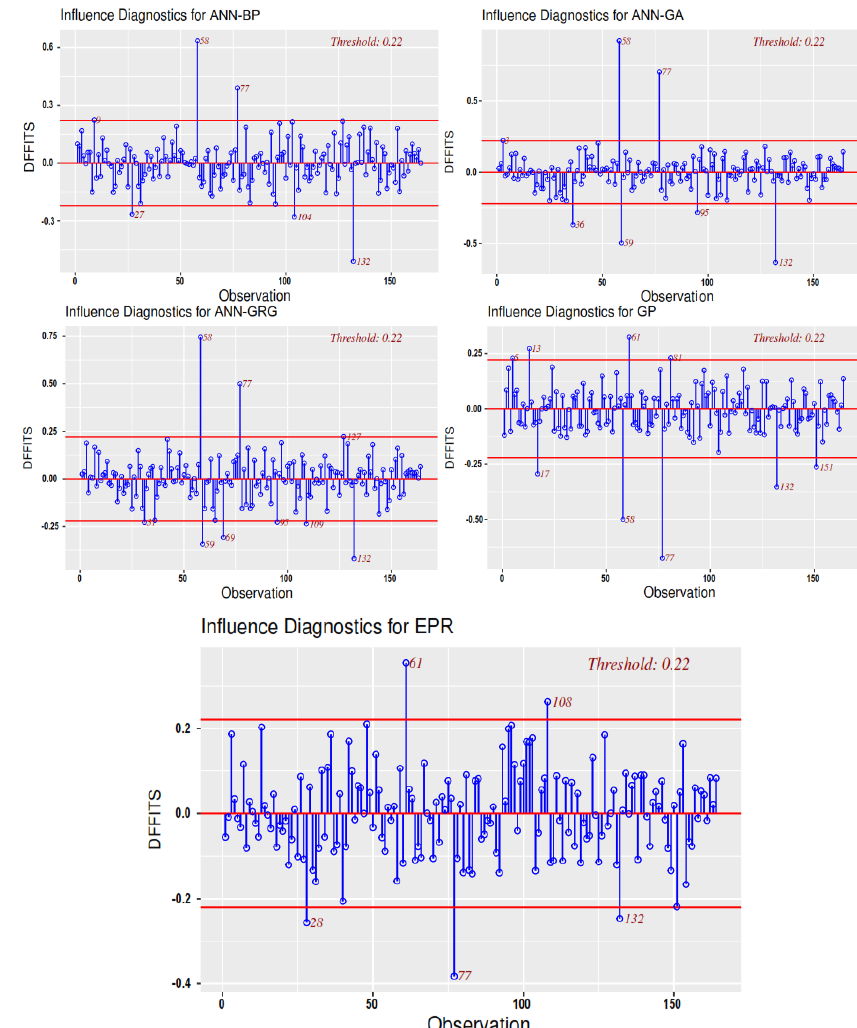
Figure 8. DFFITS plots for the predictive models.